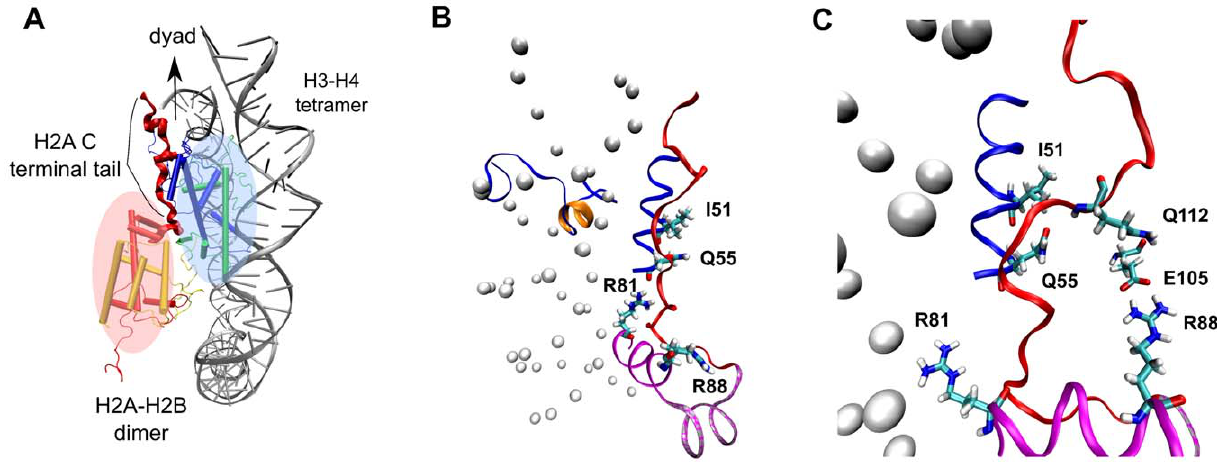
Figure 14. Regulation of nucleosome stability through H2A docking domain contacts. (A) Positions of the H2A–H2B dimer and H3–H4 tetramer in a nucleosome illustrating that the interaction surface between the H2A–H2B dimer and H3–H4 tetramer is provided by the H2A C terminal tail. Histone dimers H3, H4, H2A and H2B are colored in blue, green, red and yellow, respectively. Part of the nucleosome structure is shown in cartoon representation for clarity of vision. (B)–(C) Disruption of contacts between the H3 tail a -helix (colored orange) and the DNA triggers change of interaction of histone arginines (Arg81 and Arg88). Newly formed polar contacts between Arg88, Glu105 and Gln112 destabilizes interaction of the H2A docking domain with closely lying amino acids (Ile51 and Gln55). Histone protein domains are shown as ribbons and DNA phosphorous atoms are shown as spheres. Histone domains are color coded as follows : H3 a N (blue), H2A a 3 (magenta), H2A a C (grey), H2A docking domain (red).